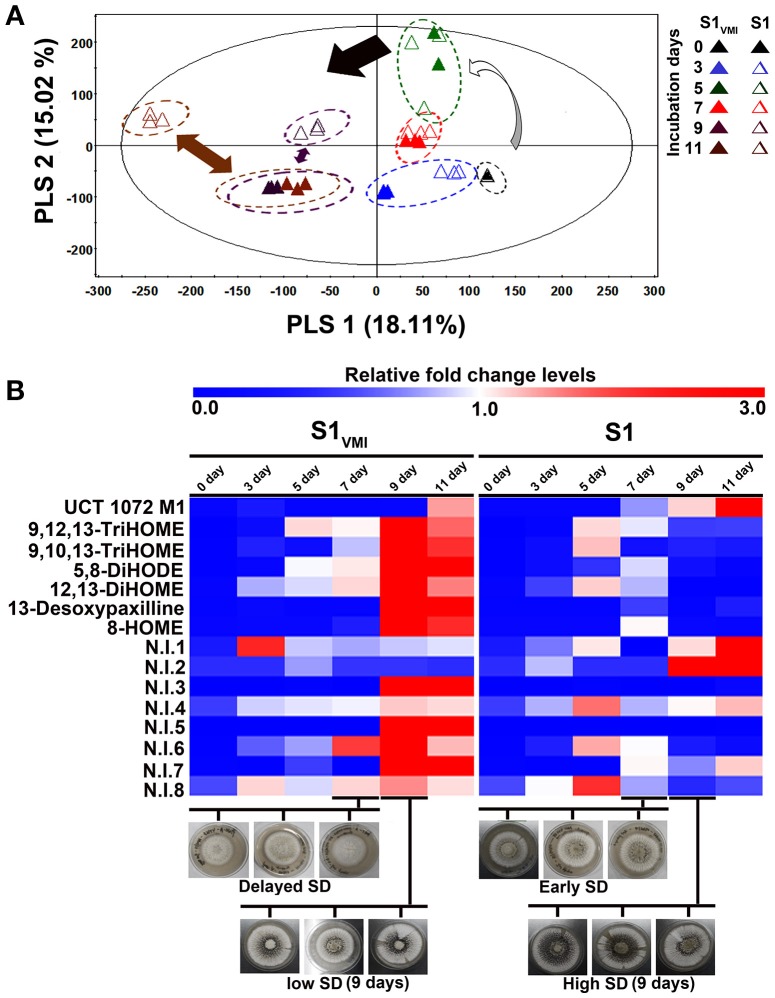
A time-correlated (A) PLS-DA score plot displaying the clustering patterns of metabolite, and (B) the heat map representation for the relative fold change levels of significantly discriminant metabolites (VIP > 0.7, p < 0.05), derived from UHPLC-LTQ-IT-MS/MS detected secondary metabolite datasets for A. oryzae RIB 40 (S1VMI and S1) sample extracts.